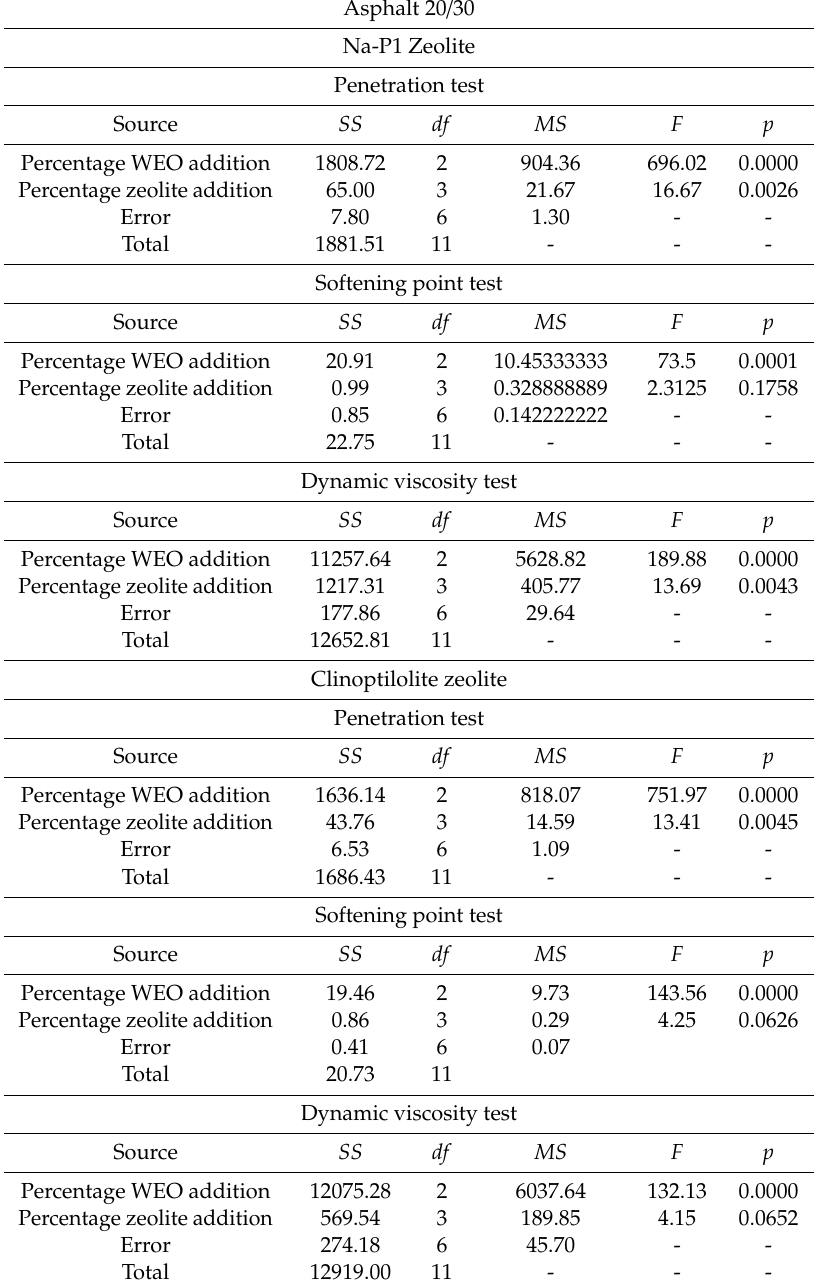
Table 3. ANOVA analysis on the parameters of the waste engine oil (WEO)-modified